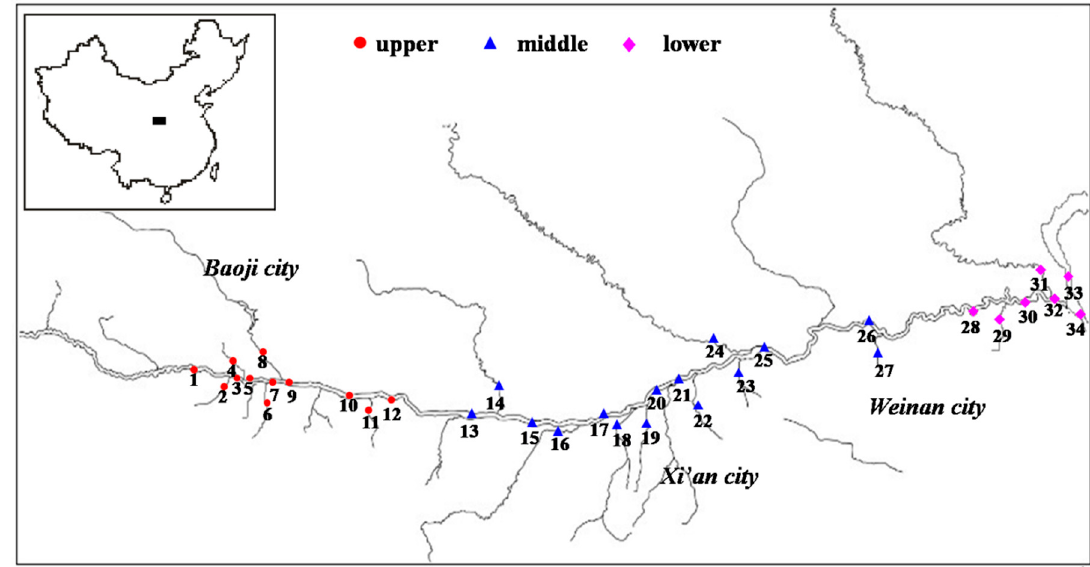
Figure 1. Sampling location of surface sediments in Weihe River Basin Shaanxi section, China [12].